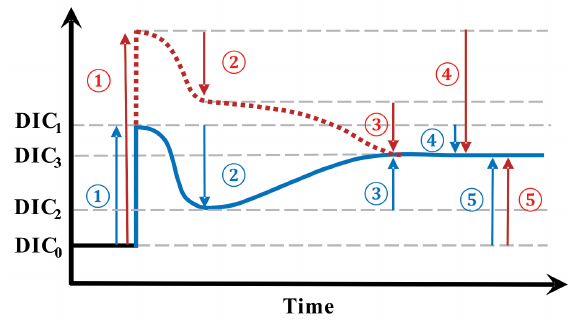
Figure 6. A schematic illustrating the various effects of upwelling on surface DIC. Numbers represent processes changing surface DIC, and arrows point in the direction of change. (1) The di- rect effect of upwelling which elevates surface DIC from DIC 0 to DIC 1 ; (2) the DIC uptake by biology supported by upwelled nutri- ents, dropping DIC from DIC 1 to DIC 2 . The processes of (1) and (2) make up the short-term effect of upwelling (i.e., difference be- tween DIC 2 and DIC 0 ); (3) the change brought about by air–sea CO 2 gas exchange which continues towards the equilibrium with the atmosphere (DIC 3 , whose level is determined by the amount of upwelled TA as well as by temperature); (4) the combination of both (2) and (3) makes up the total indirect effect of upwelling (the difference between DIC 3 and DIC 1 ); (5) the long-term impact of upwelling on the level of surface DIC is the difference between DIC 3 and DIC 0 . Blue and red indicate two scenarios with differ- ent amounts of upwelled DIC relative to upwelled TA, but the same amounts of upwelled TA. Blue is for upwelled water with a deficit in additional DIC relative to additional TA whereas red is for an excess in DIC relative to